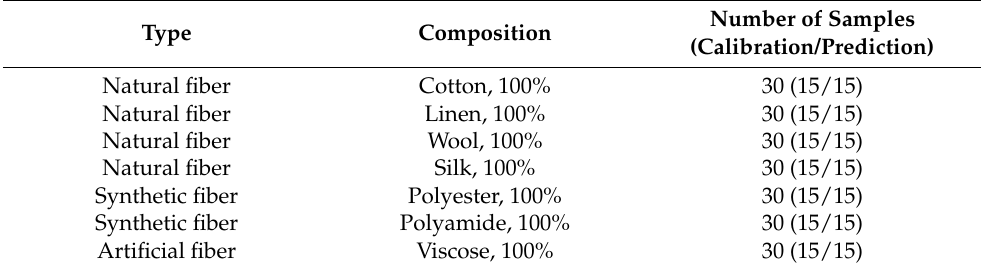
Table 1. Textile Samples Analyzed in Study No. 1.